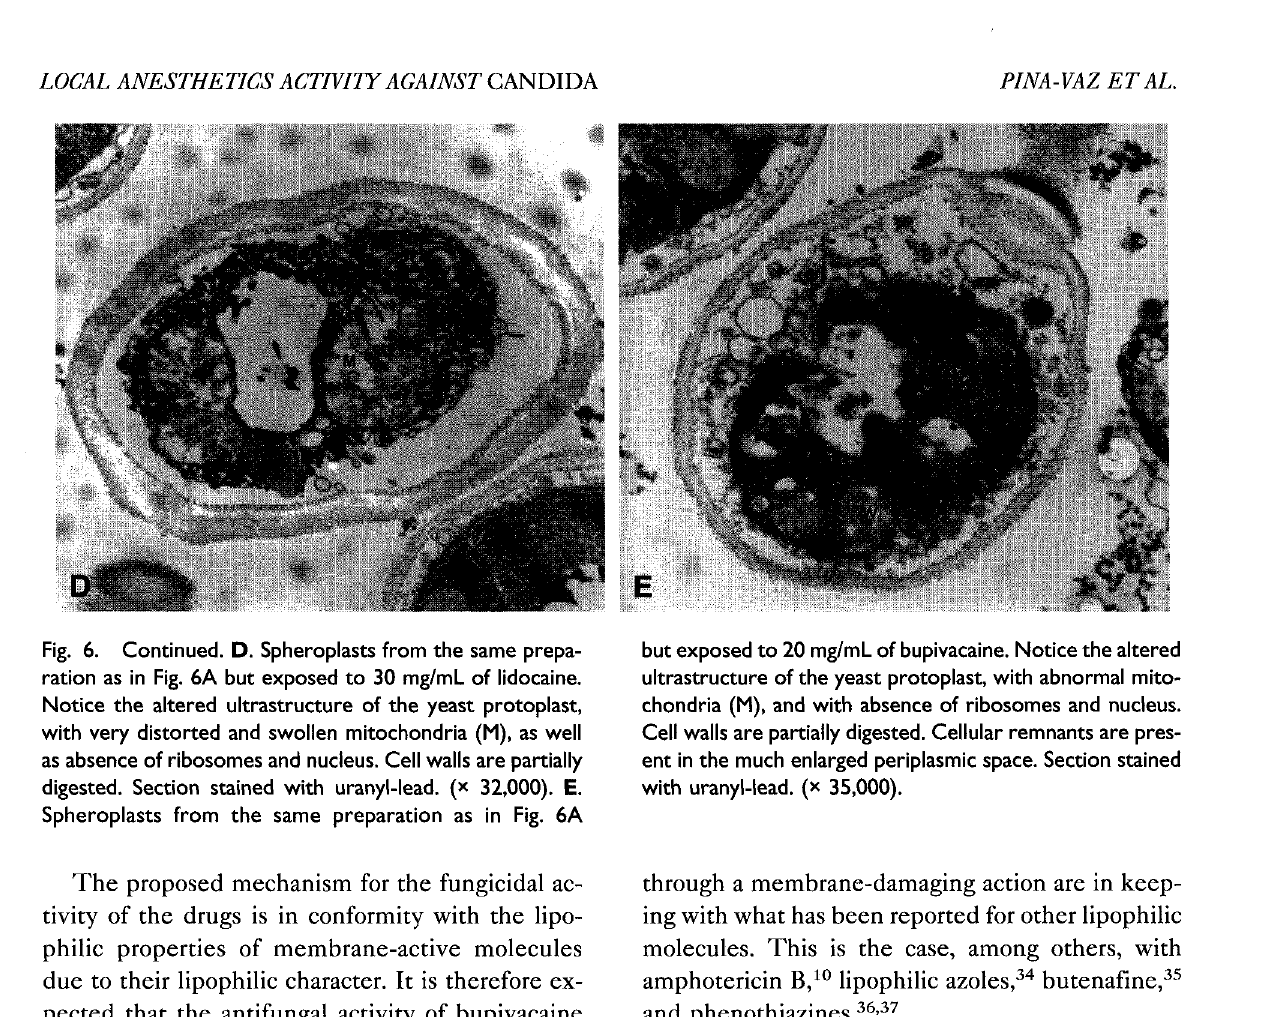
Fig. 6. Continued. 13. Spheroplasts from the same prepa- ration as in Fig. 6A but exposed to 30 mg/mL of lidocaine. Notice the altered ultrastructure of the yeast protoplast, with very distorted and swollen mitochondria (M), as well as absence of ribosomes and nucleus. Cell walls are partially digested. Section stained with uranyl-lead. (x 32,000).